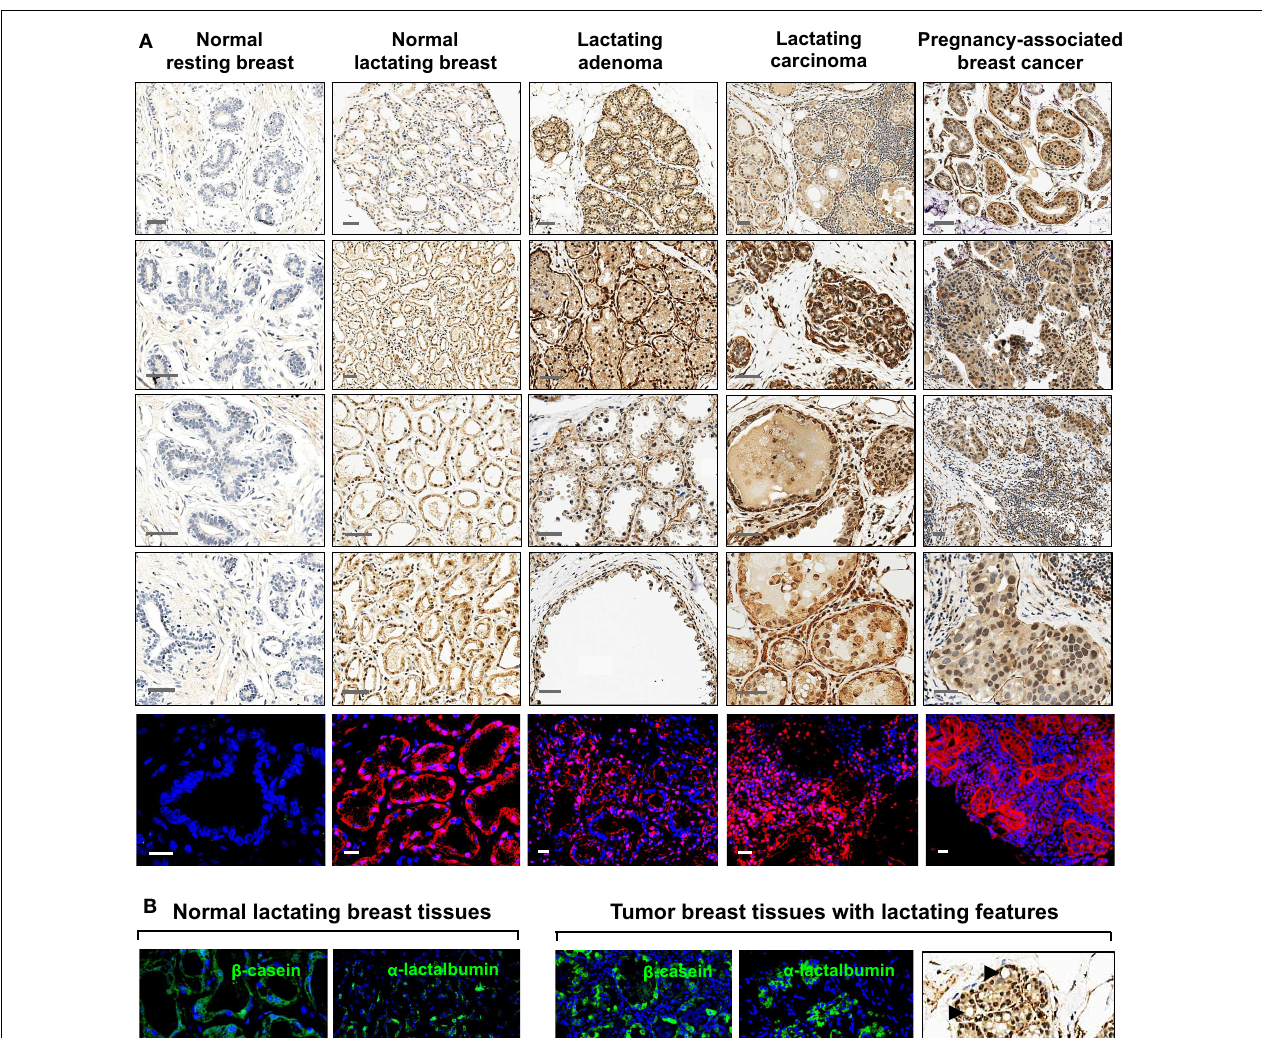
between different lobules and alveoli within the same tissue. Enhanced expression was observed in breast tumors with lactating features or associated with pregnancy and lactation. In addition to the epithelium, some expression was seen in the mammary stroma. (B) The lactating features of the examined normal lactating and tumor tissues were confirmed via IF staining for milk proteins and the presence of lipid droplets in the epithelium. Scale bars: 10 µ